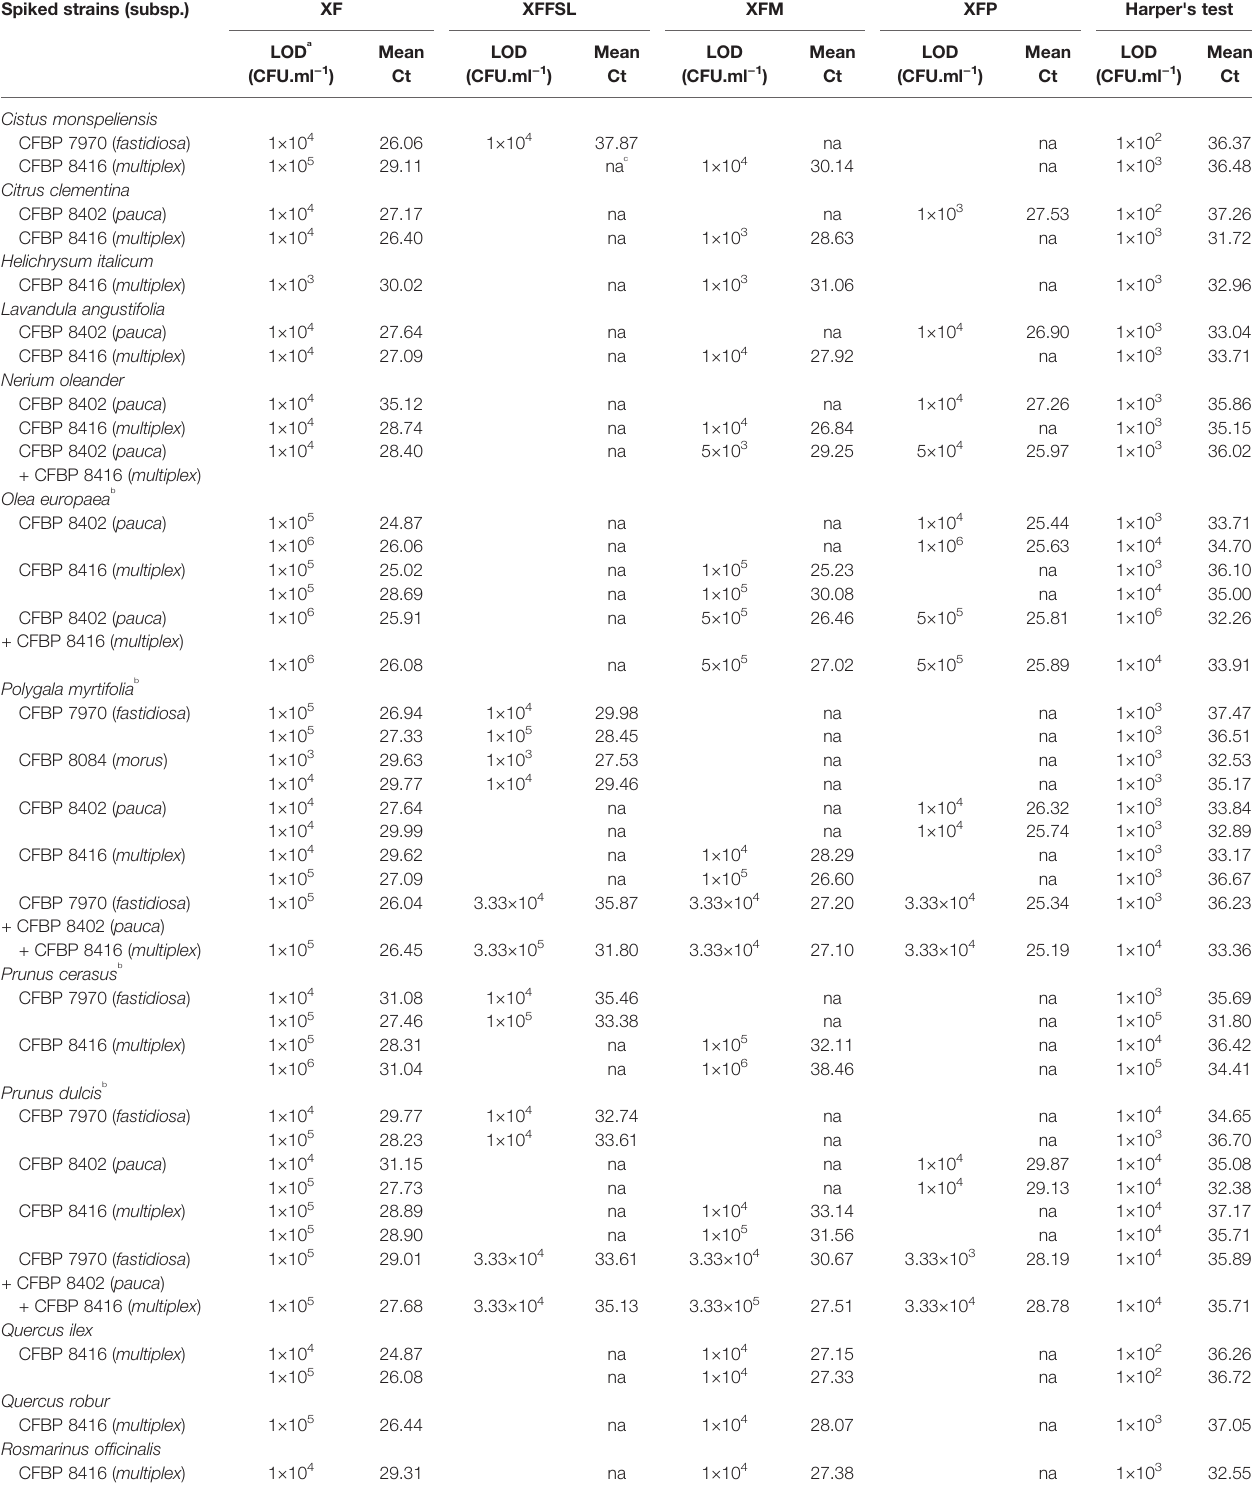
TABLE 5 | Limit of detection (LOD) of X. fastidiosa strains in spiked matrices using the tetraplex qPCR assay XF – XFFSL – XFM – XFP (set n°1) in comparison with the reference test (Harper's test, Harper et al., 2010). Spiked strains